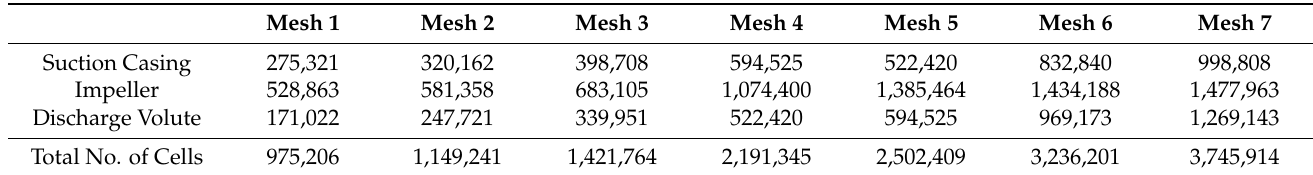
Table 2. Mesh domain for grid sensitivity analysis.